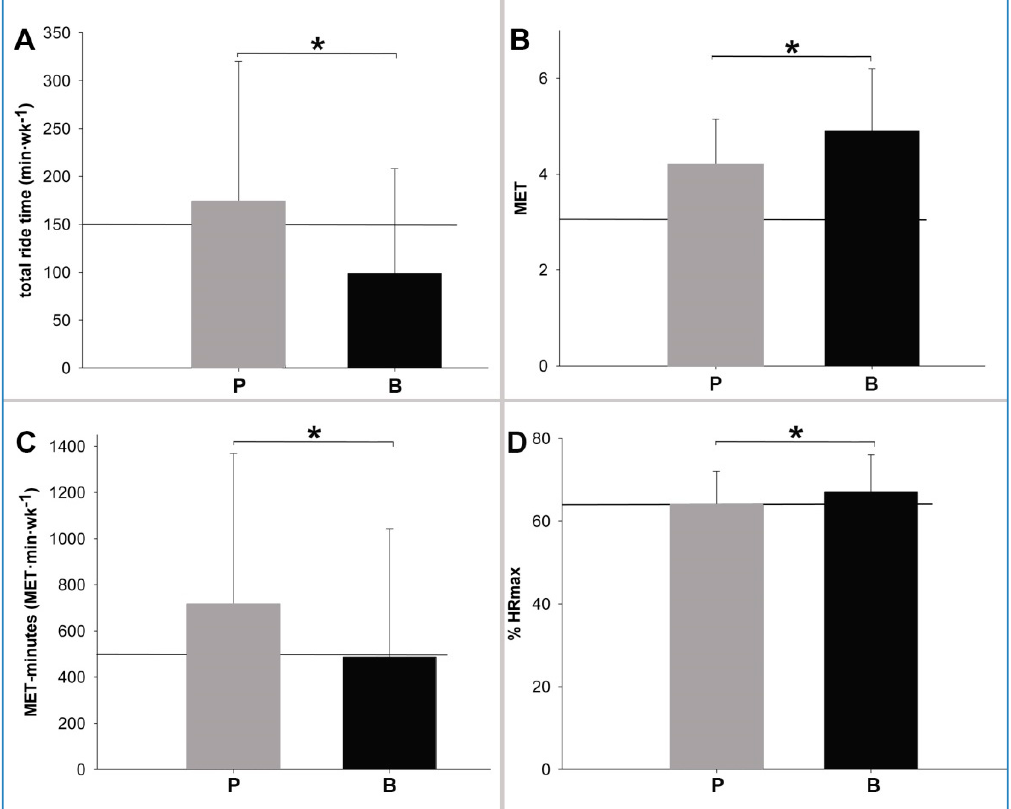
Figure 2. ( A ) Total ride time; ( B ) single trip intensity; ( C ) weekly metabolic rate; ( D ) mean intensity classified by %HR max ; P—light grey: During pedelec use; B—dark grey: Bicycle use; The solid line shows the minimum requirements for moderate-intensity exercise as recommended by the ACSM; Significant differences between activity types ( p < 0.05) are marked with a